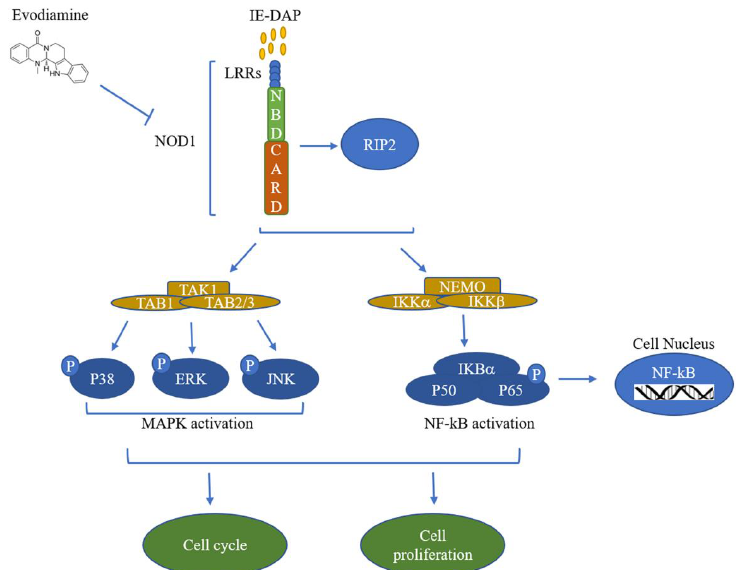
Figure 6. Model of NOD1 signaling cascade. Nucleotide-binding oligomerization domain 1 (NOD1) characterized by three motifs containing a C-terminal leucine-rich repeat (LRR) domain, a central nucleotide-binding domain (NBD), and a variable N-terminal caspase recruitment domains (CARD), which could be activated by γ -D-Glu-mDAP (IE-DAP). NOD1 recruits the adaptor RIP2 and